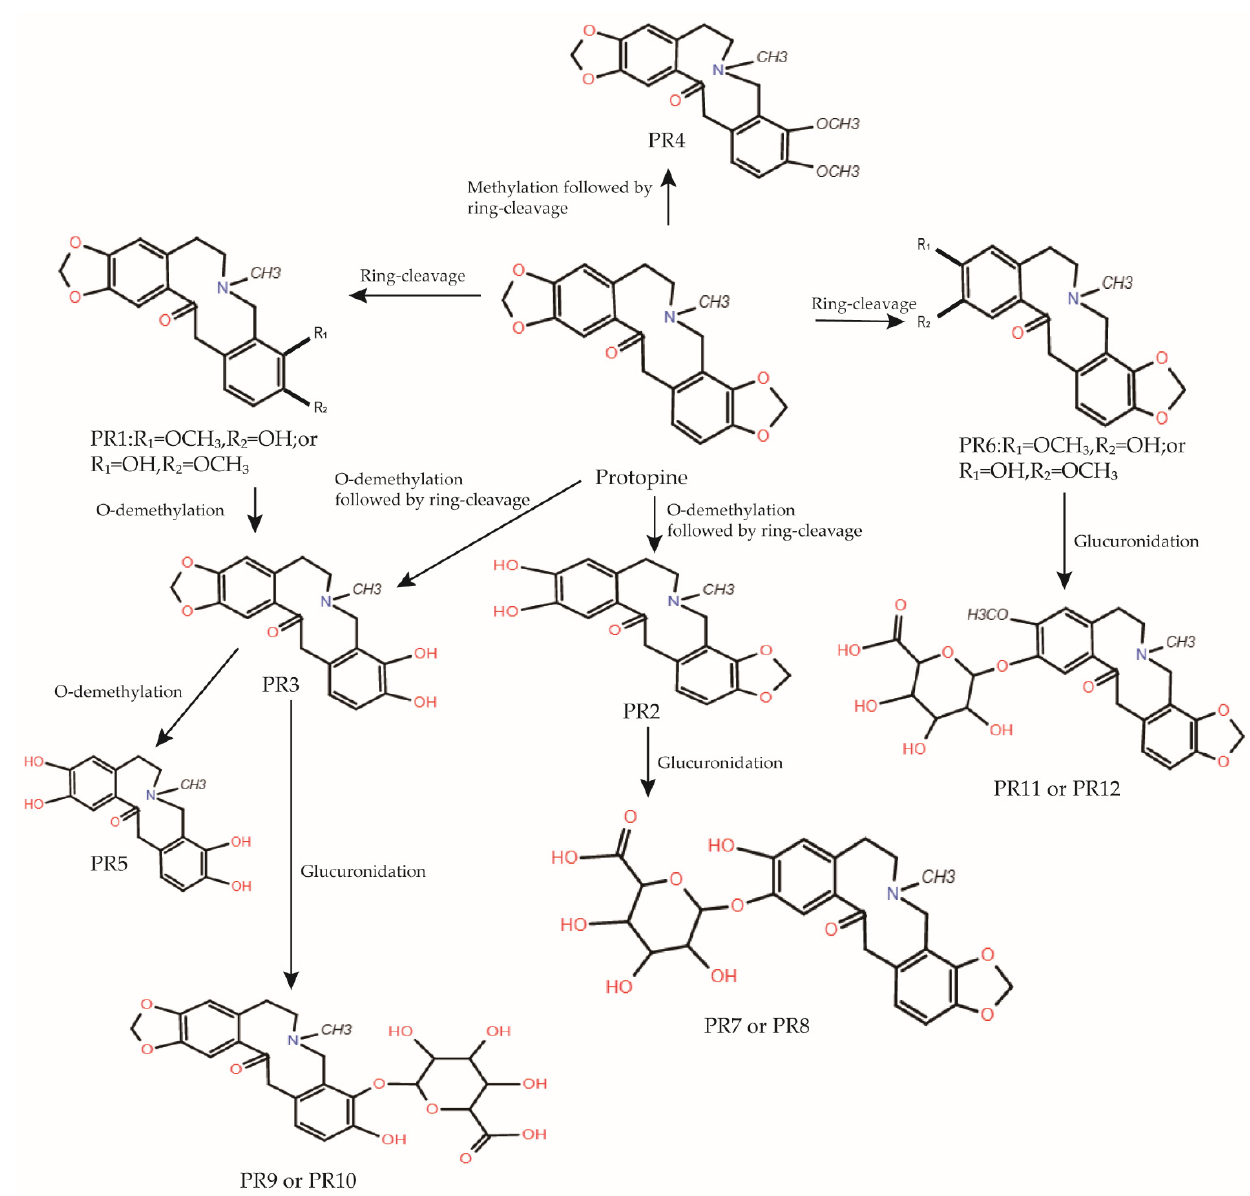
Figure 2. Proposed metabolic pathways of Protopine in rats in vivo [5,21].